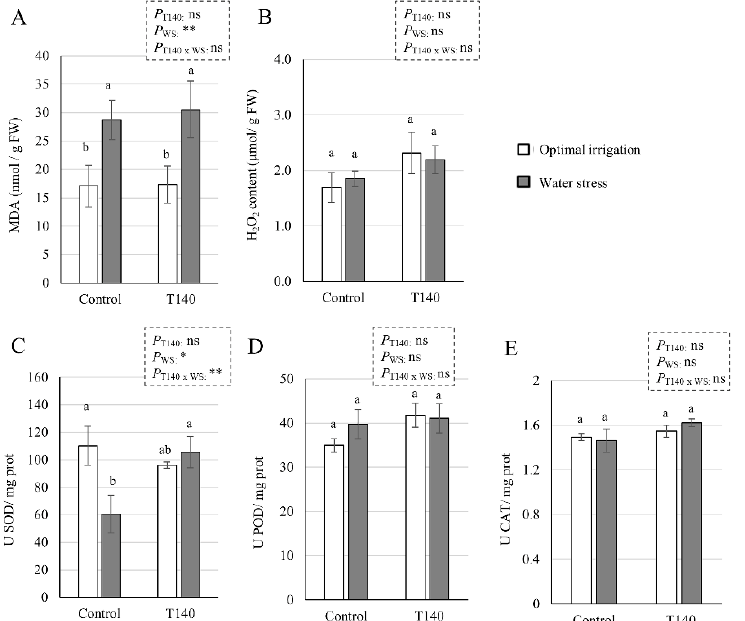
Figure 8. Effect of strain T140 application compared to plants not treated with T140 (control) on ( A ) the MDA and ( B ) H 2 O 2 content, and the antioxidant activity of ( C ) SOD, ( D ) POD, and ( E ) CAT in N-fertilized 25-week-old wheat plants under optimal irrigation and water stress (WS, 1/2 watering applied) conditions. Data were calculated from three replicates for each treatment and irrigation condition ( n = 3), and different letters above the bars indicate significant differences according to one-way analysis of variance (ANOVA) followed by Tukey’s test ( p < 0.05). For each set of data, the effect of significance was determined using a two-way ANOVA for “T140 application”, “WS”, and